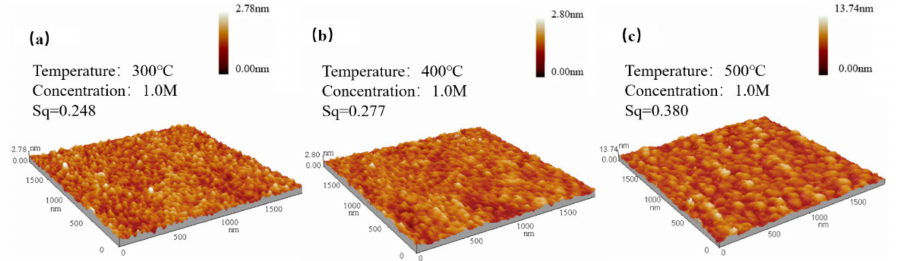
Figure 5. ZYAMO thin film AFM images of 1.0 M after different temperature annealing: ( a ) 300 ◦ C, ( b ) 400 ◦ C, and ( c ) 500 ◦ C.